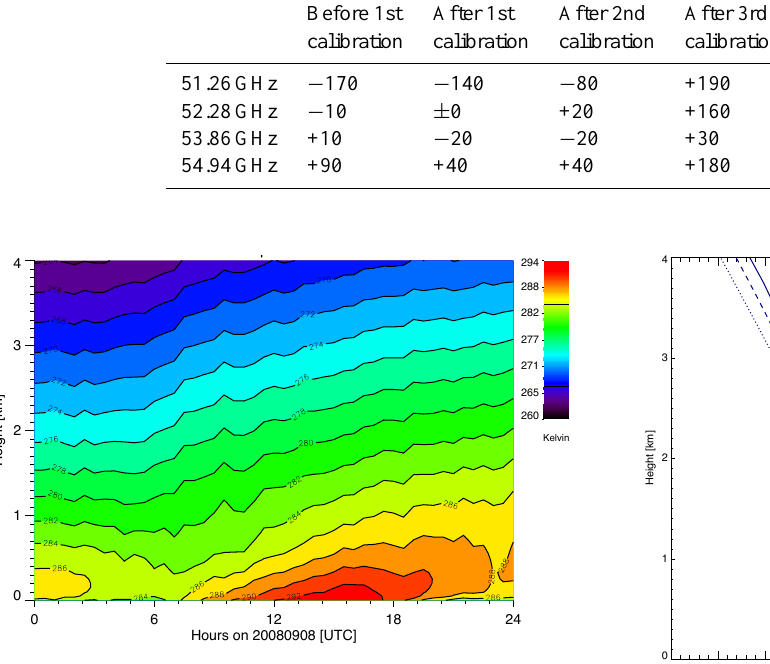
Figure 5 : MWR-retrieved time-height temperature contours between 0 and 4 km on 09 September, 640 Fig. 5. MWR-retrieved time-height temperature contours between 0 and 4km on 9 September 2008.